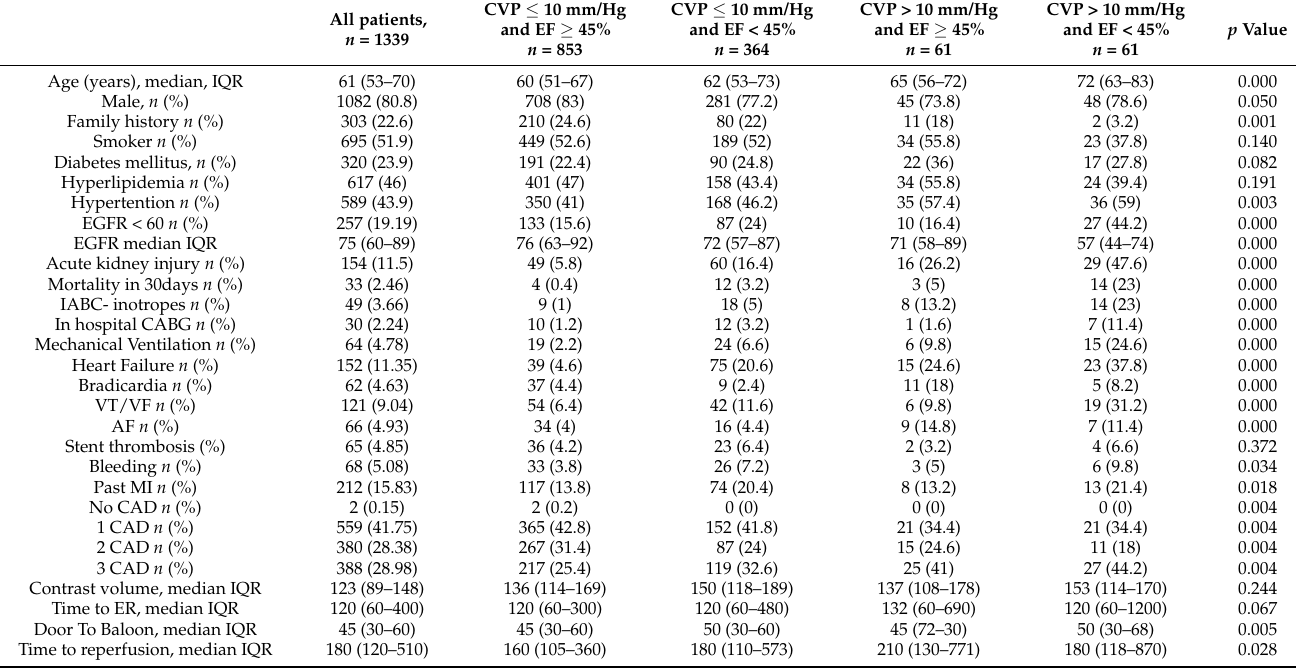
Table 1. Patients’ baseline criteria based on cardiac function.